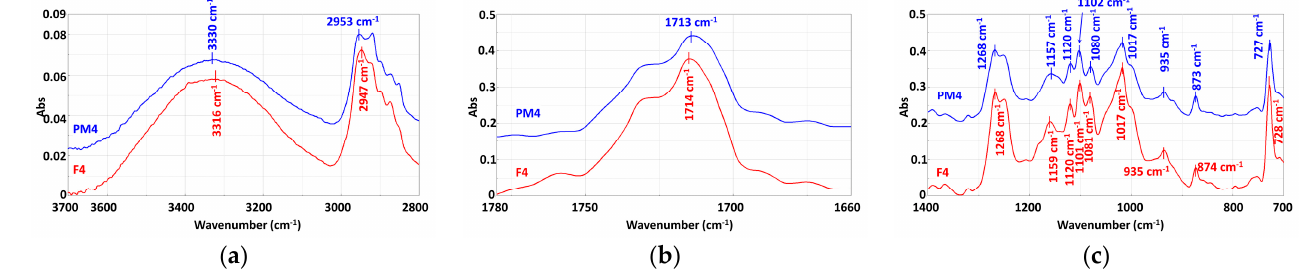
Figure 10. FTIR spectra of the PM4 and F4 compounds: ( a ) 3700–2800 cm − 1 ; ( b ) 1780–1680 cm − 1 ; ( c ) 1400–700 cm − 1.